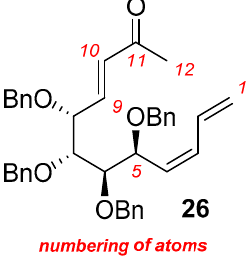
Figure 8. The structure of triene 26 and the numbering of the atoms.